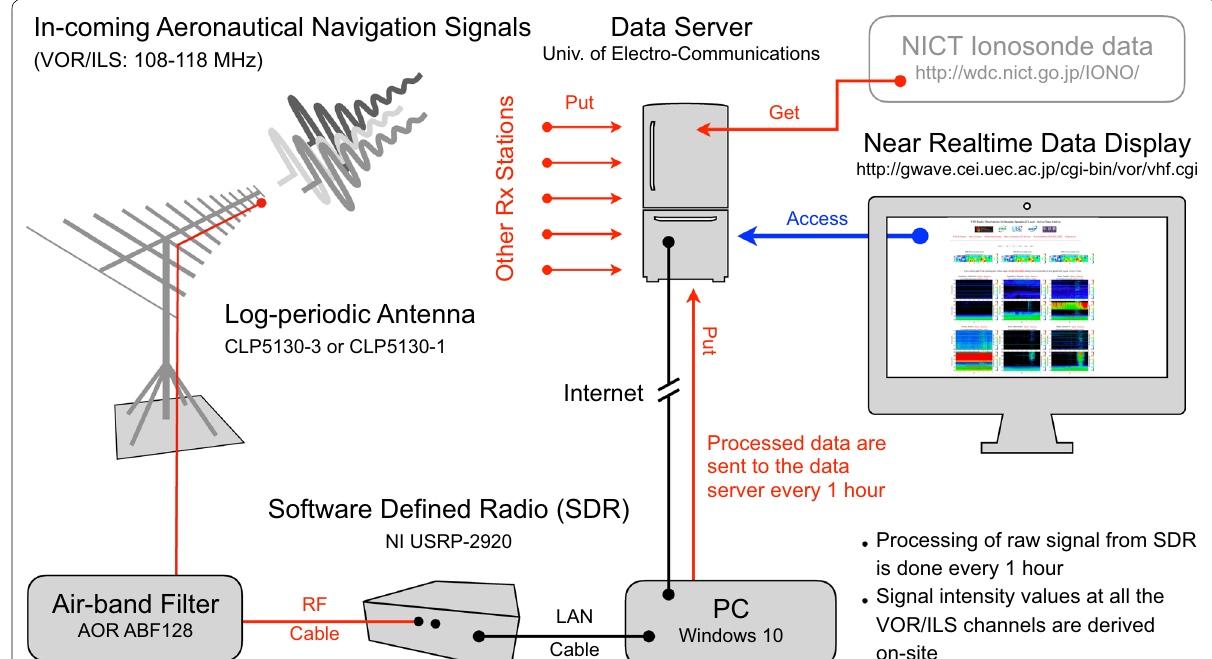
Fig. 2 A block diagram of the receiving system and near real-time monitoring